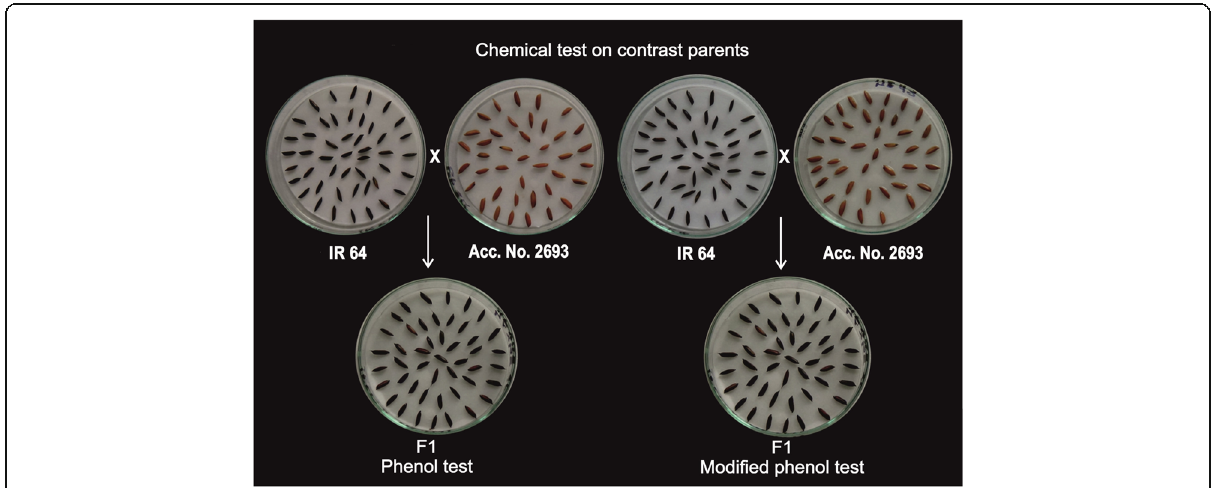
Fig. 3 Colour formation in aleurone layer of parents IR 64 (dark brown colour), Acc. No. 2693 (light brown/No reaction) and their F 1 progeny (dark brown colour) with phenol and modified phenol tests